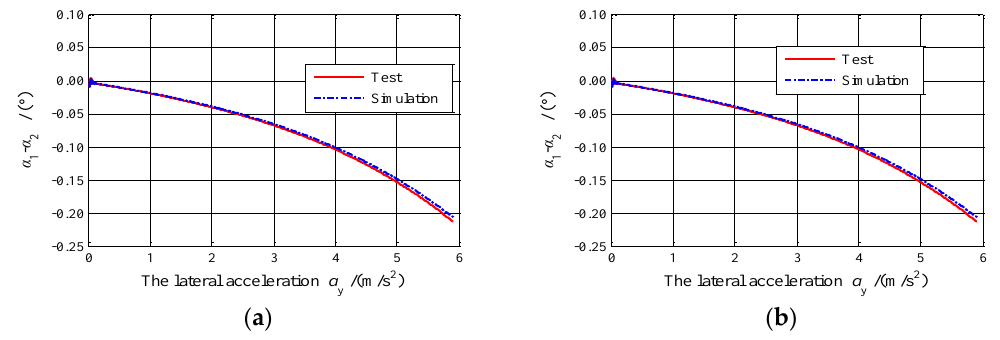
Figure 9. A comparison of the curves of α 1 -α 2 versus the lateral acceleration for the truck with: ( a ) The multi-leaf spring, and ( b ) the taper-leaf spring.